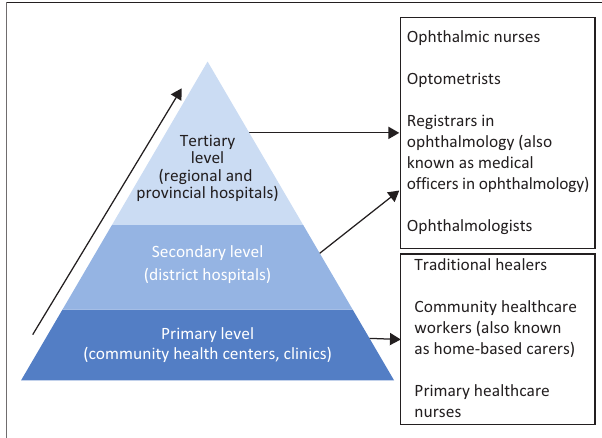
FIGURE 3: Levels of eye care service delivery and related cadres in Limpopo Province of South